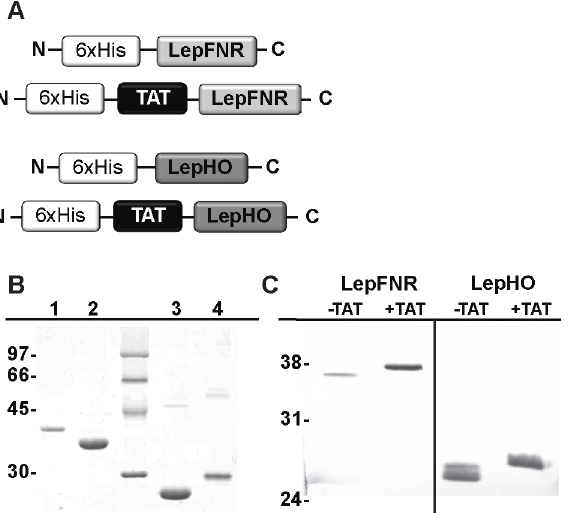
Fig 1. Protein design, expression and purification. (A) Schematic representation of wild type and TAT fusion forms of LepHO and LepFNR. (B) Purified fractions of each recombinant loadedinto 12% SDS-PAGE and subsequently stained with Coomassie blue: lane 1, His-TAT-LepFNR (39.1 kDa); lane 2, His-LepFNR (37.6 kDa); lane 3, His-LepHO (28.4 kDa); Lane 4, His-TAT-LepHO (29.9 kDa). (C) Western blot analysisof purifiedproducts using primary antibodiesanti-LepFNRand anti-LepHO raised in rabbits.